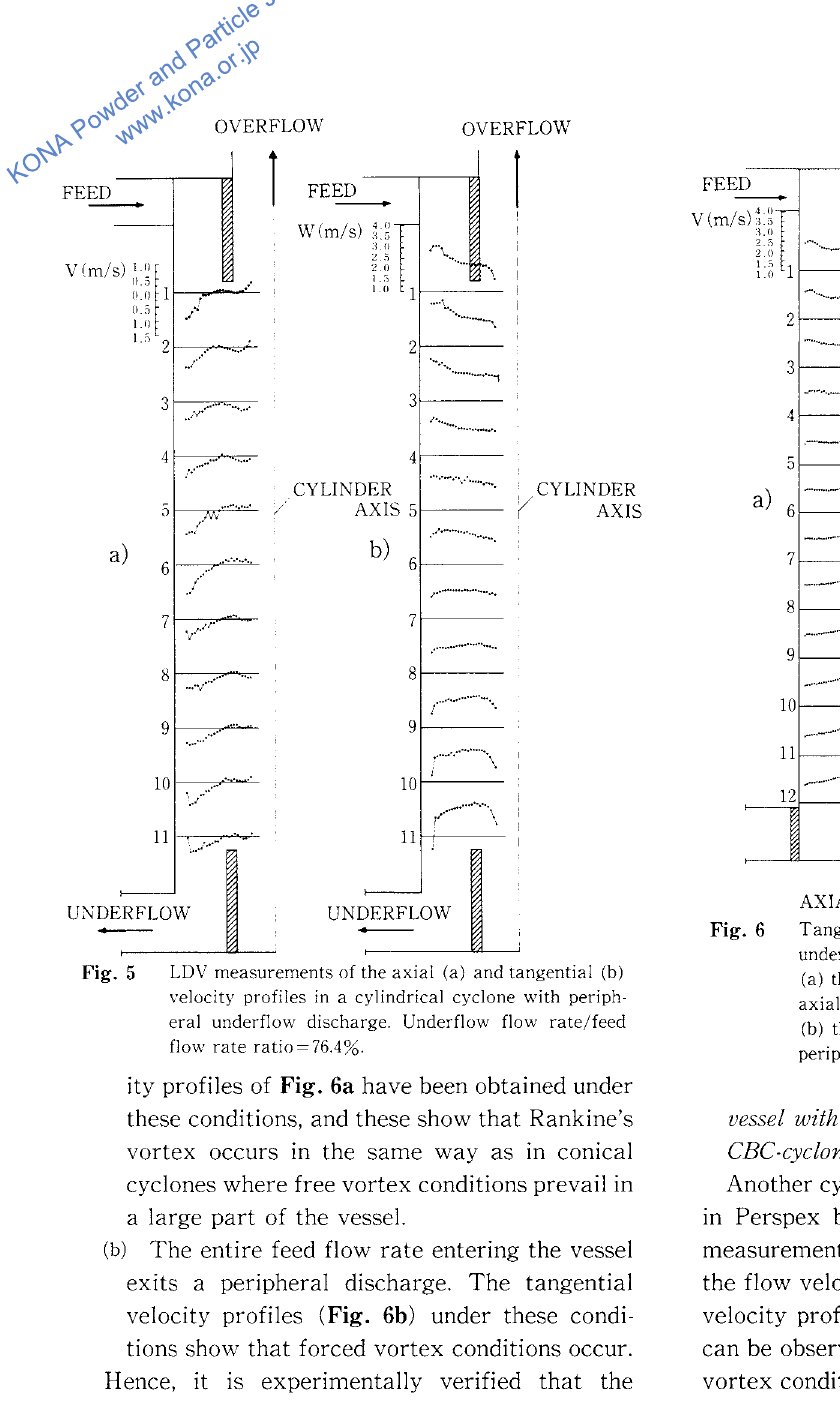
Tangential velocity profiles in a cylindrical vessel under different discharge conditions: (a) the entire feed flow rate entering the vessel exits an axial discharge; (b) the entire feed flow rate entering the vessel exits a peripheral